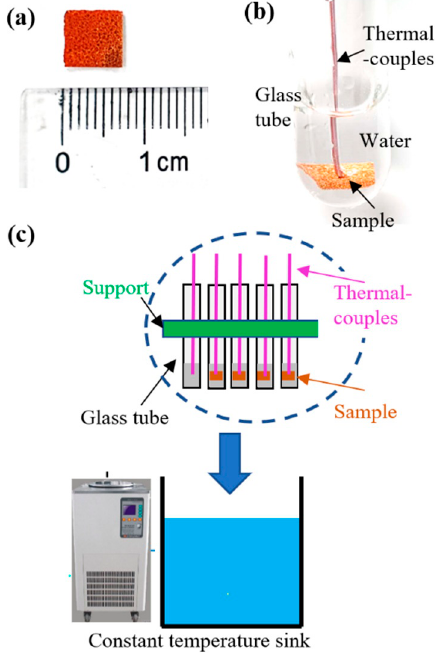
Figure 2. Test setup for the cool storage phase-change process. ( a ) Test sample with the dimensions of 7 mm (L) × 7 mm (W); ( b ) test sample inside the glass tube; ( c ) entire system.